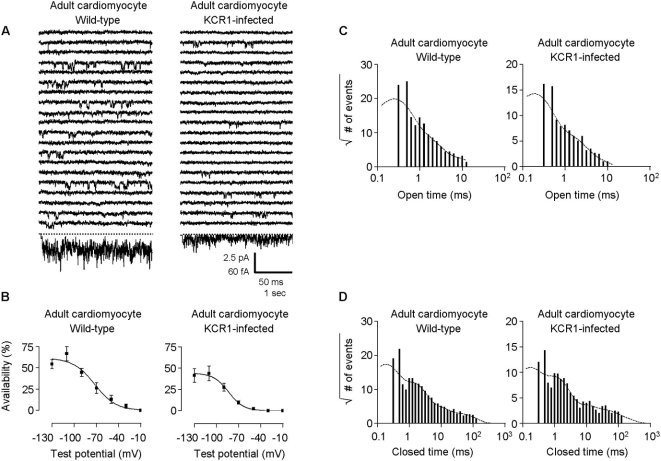
Effect of KCR1 on single native If channel gating in one-channel patches.(A) Comparison between single native If channels of control adult ventriculocytes (left) and KCR1-infected cells (right). Recording technique as in Figure 3. Scale bars, 50 ms, 2.5 pA for unitary current traces, and 1 s, 60 fA for ensemble average current. (B) KCR1 significantly shifted If activation to more negative potentials. Channel activation was measured by the parameter availability, plotted against the test potential and then determined by using the Boltzmann function. For data see text. (C) Open-time histograms: KCR1 exhibited no effect on the number of native If open states. Number of open events (square root) were plotted against the logarithmically binned open time durations for If alone and with exogenous KCR1 (pooled one- and multi [n≤3]-channel experiments). (D) Closed-time histograms: KCR1 did not affect the number of native If closed states. Number of closed events (square root) were plotted against the logarithmically binned closed time durations for If alone and with exogenous KCR1 (pooled one-channel experiments only).